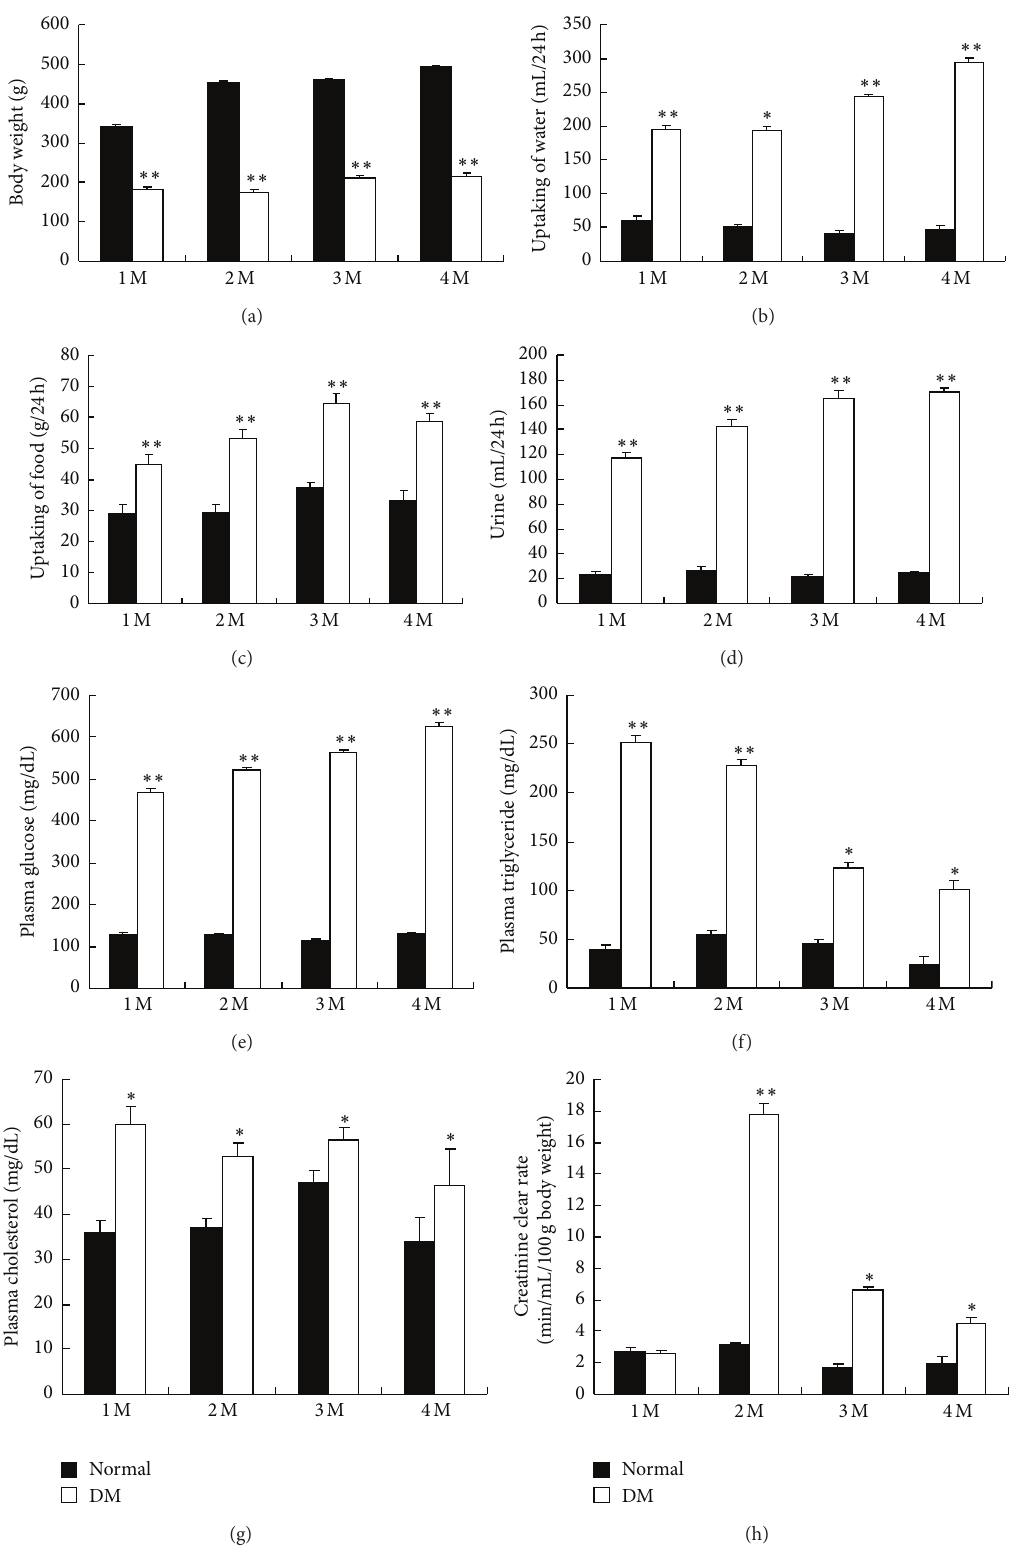
Figure 1: Metabolic parameters of rats at four consecutive months after STZ injection. (a) Body weight, (b) water absorption/24h, (c) food absorption/24h, (d) urine/24 h, (e) plasma glucose, (f) plasma triglyceride, (g) plasma cholesterol, (h) creatinine clear ratio. ∗ 𝑃 < 0.05 denotes significant difference compared with the age-matched control rats. ∗∗ 𝑃 < 0.01 , significant difference compared with the age-matched control rats; 𝑛 = 18